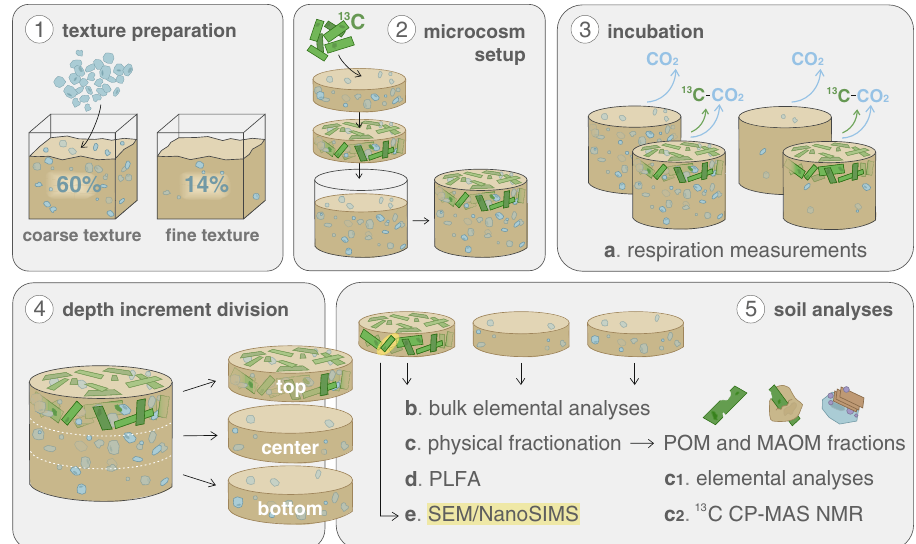
Fig. 9 Experimental setup of 13 C labeled litter incubation in soils with different textures. ( 1 ) The coarse soil texture was obtained by adding quartz sand to the loamy soil material, achieving a total sand content of 60% compared to 14% in the fi ner-textured soil consisting only of the original soil material. ( 2 ) The uppermost layer of the microcosm was prepared by mixing 13 C labeled plant litter with homogenized soil. Two-thirds of the microcosms were fi lled with soil material, and the prepared litter layer was added as the top layer in respective textures. ( 3 ) Five replicates for each of the four treatments (two soil textures with or without plant litter added) were incubated for 95 days. Respiration measurements ( a ) were carried out on all fi ve replicates. ( 4 )